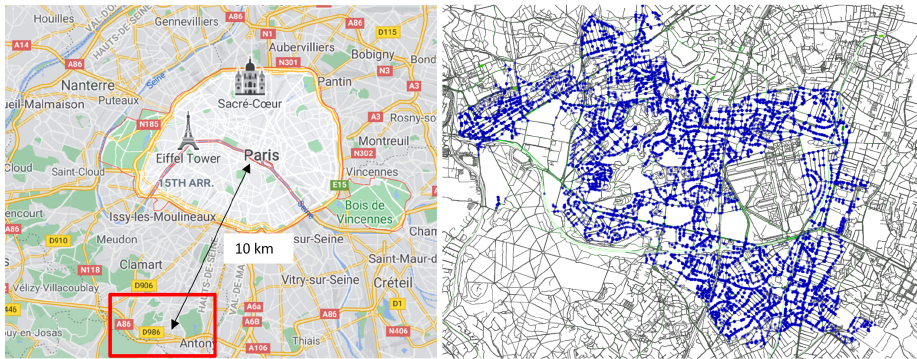
Figure 25. The region of interest is a suburban area 10 km from Paris, France. Its population amounts to 126k agents over five municipalities. Blue dots are Home-locations of the agents (cartography MapData ©2021